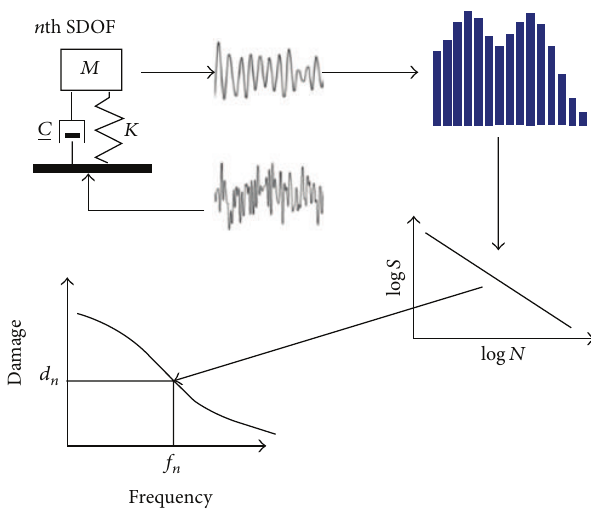
Figure 2: Calculation procedure of the FDS.